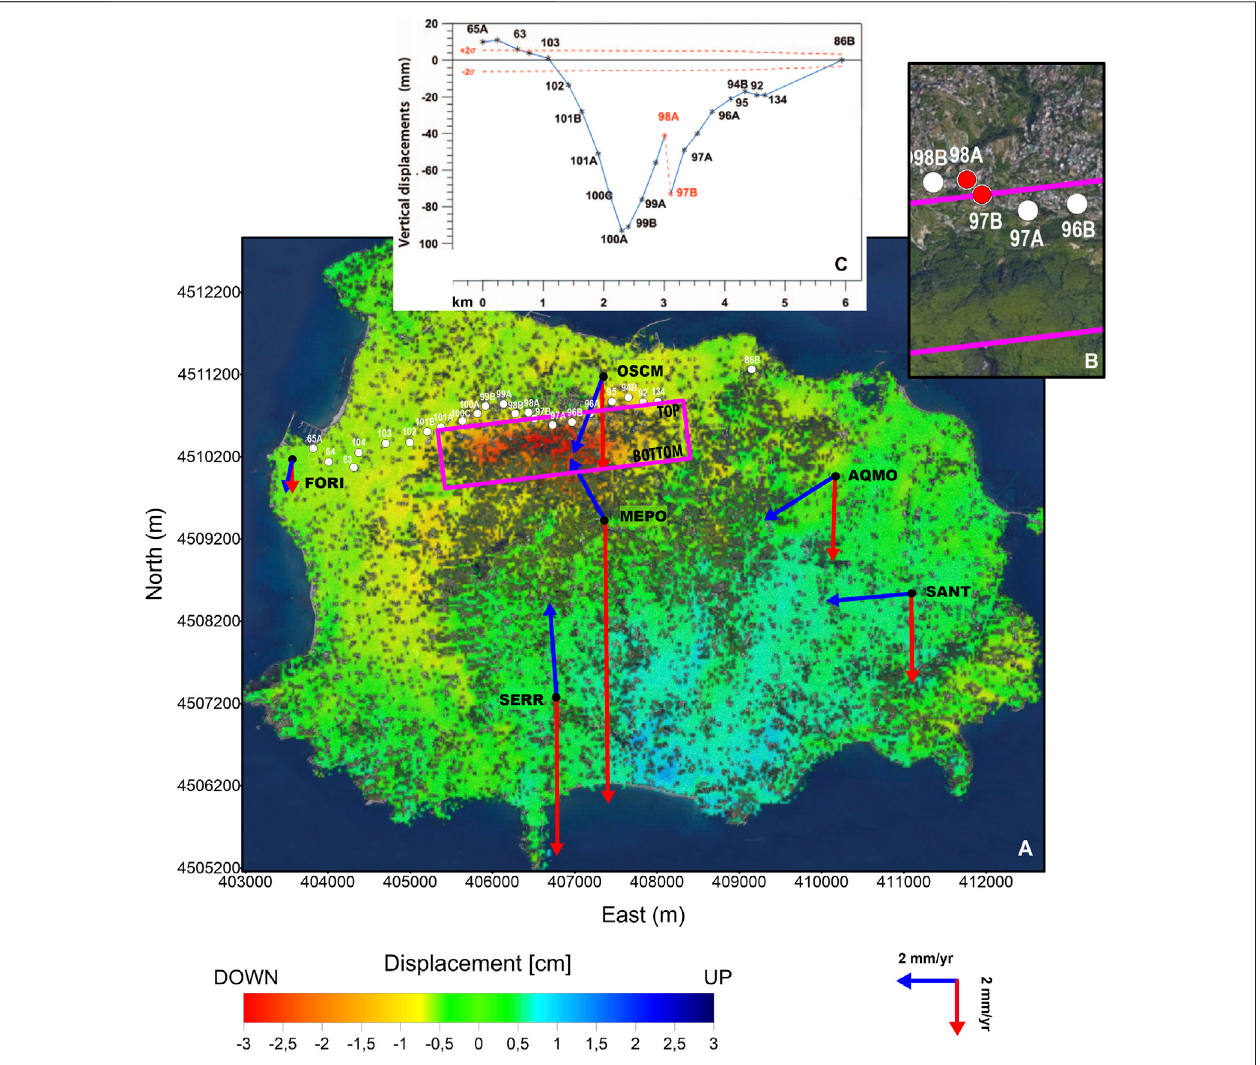
FIGURE 5 | Map of Ischia Island with indication of: (A) DInSAR vertical cosesimic displacement as shown in De Novellis et al. (2018); horizontal (blue arrows) and vertical (red arrows) GPS velocity fi eld for Ischia Island in the time spam 2001 – 2019 (after De Martino et al., 2021); benchmarks of the high precision leveling network of INGV (white points); fault projection of 2017 earthquake as inferred by De Novellis et al. (2018) (purple rectangle and fault TOP and BOTTOM). (B) Particular of the fault projection across the benchmarks 97B and 98A. (C) coseismic displacement measured by the leveling survey after the 2017 earthquake (from Ricco et al., 2019).